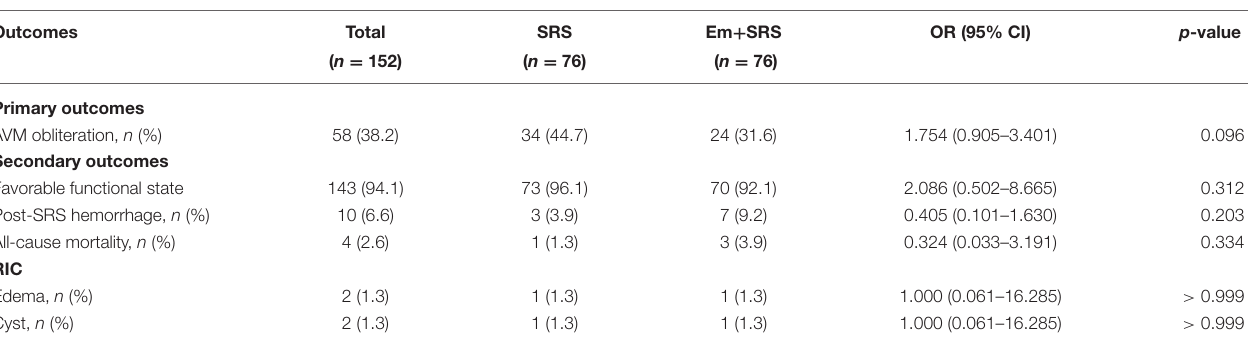
TABLE 2 | Primary and secondary outcomes of the whole